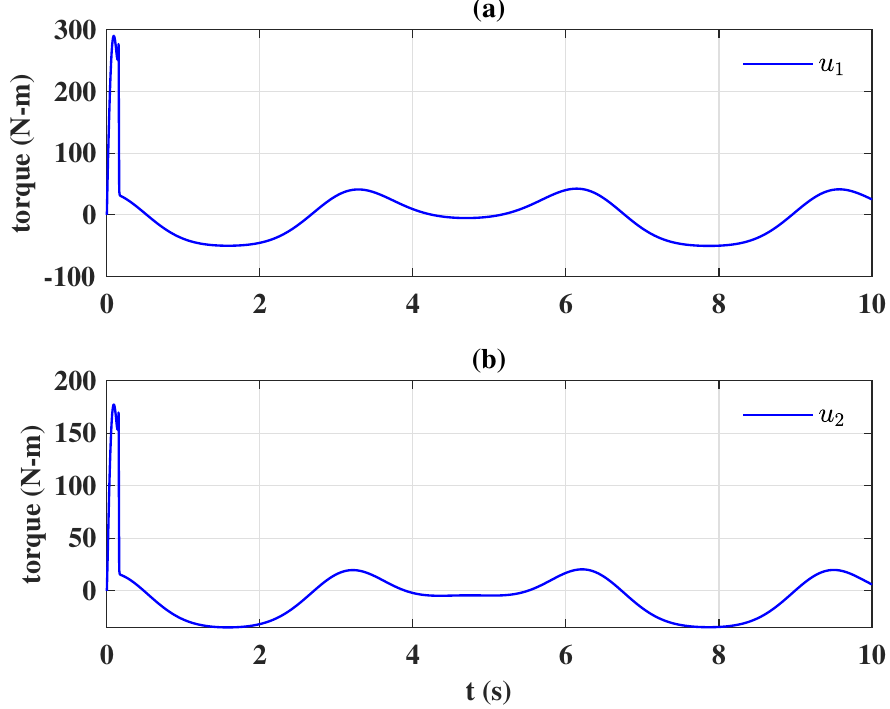
and ( b ) y 2 , y m . 2 1